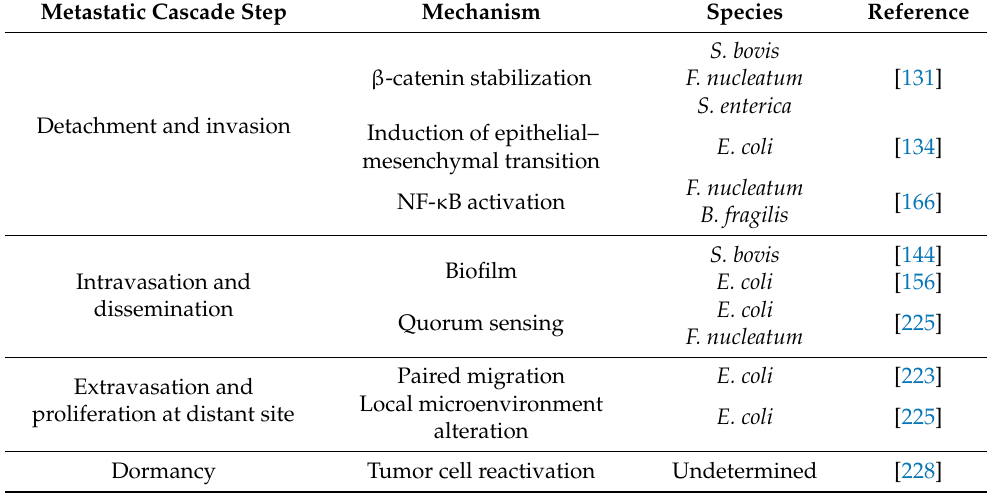
Table 3. Bacterial involvement in colorectal neoplasia progression and metastasis according to the steps of the metastatic cascade and species-specific mechanism of